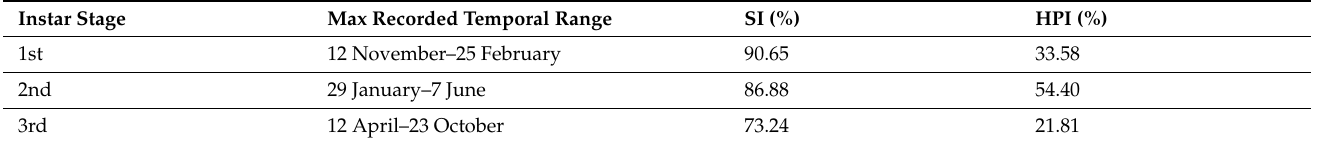
Table A2. Maximum potential temporal range of each Marchalina hellenica instar stage and the mean percent of settled insects (SI) and honeydew producing insects (HPI) across phenological records. Instar Stage Max Recorded Temporal Range